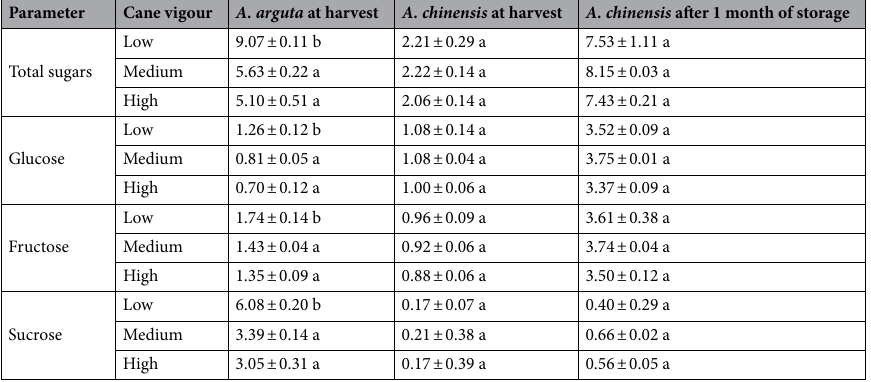
Table 5. Total and individual sugars (mean ± SE, in g/100 g fresh fruit) in fruit of A. arguta and A. chinensis . Mean values followed by the same letter within a marked column do not differ significantly.